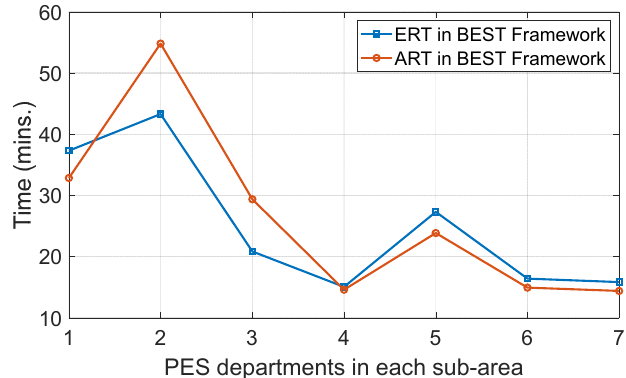
Figure 6. Evaluation of ERT and ART for PES departments.